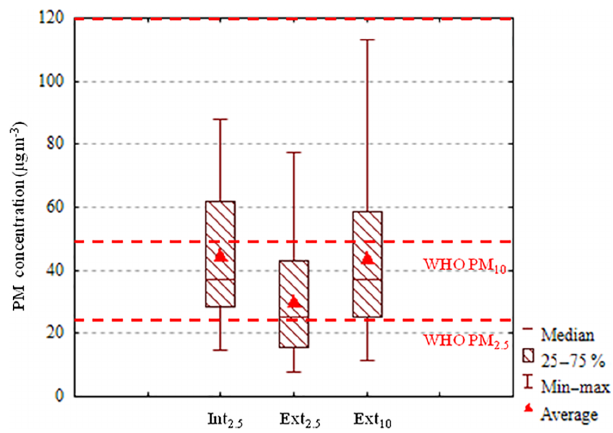
Figure 3. Box plot for particulate matter concentrations in the in- tensive and extensive